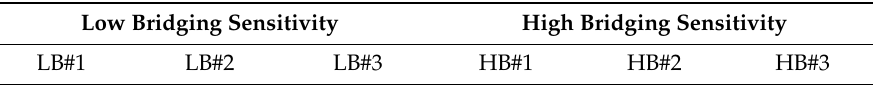
Table 2. Samples denomination.